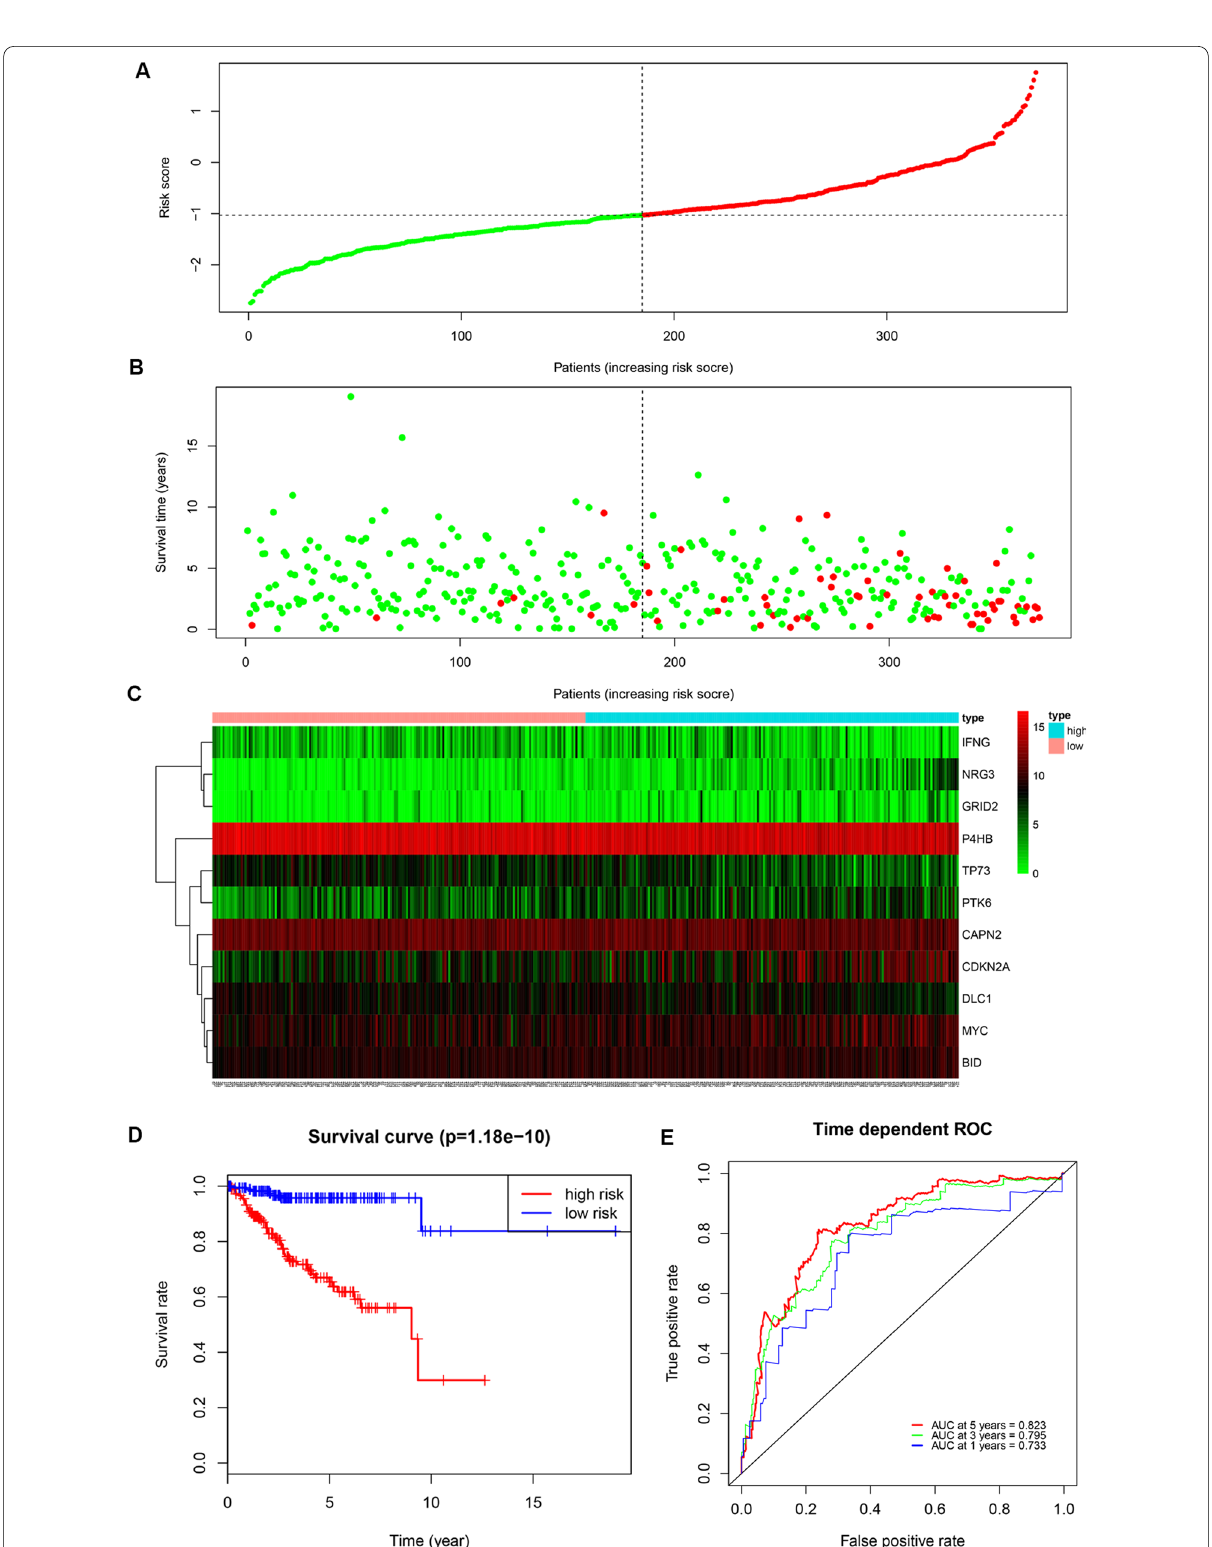
Fig. 2 Construction of prognosis prediction model of EC. A Rank of risk score and distribution of groups. B The overall survival of patients in different groups. C Expression heatmap. D Kaplan–Meier survival analysis. E Time-dependent ROC curve analysis for survival prediction by the risk